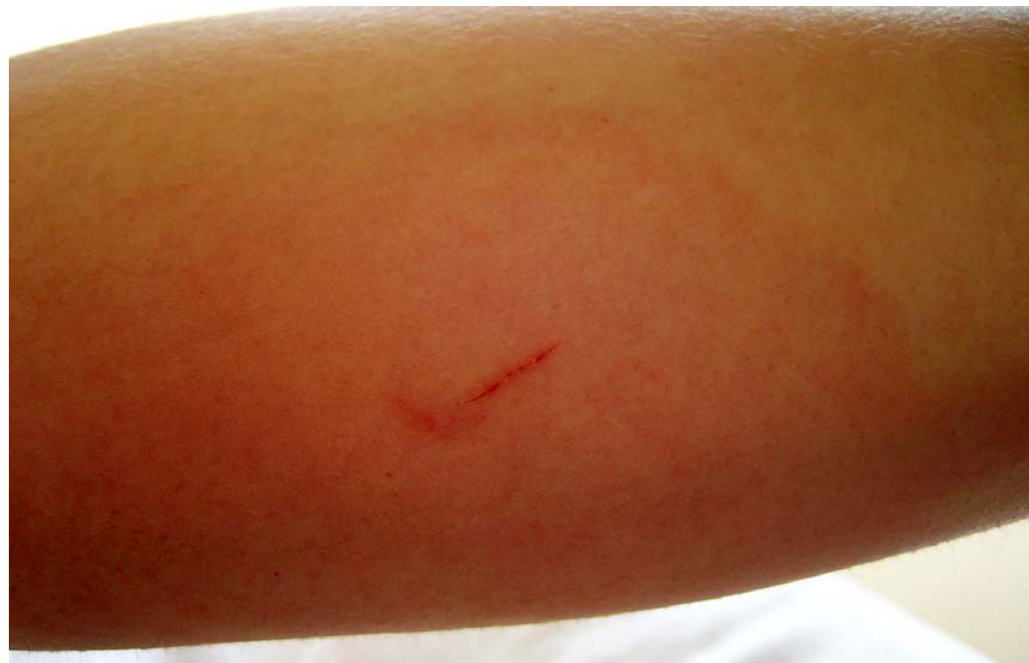
Figure 1. External halo with slight swelling observed on the left forearm, medial region (bite site).